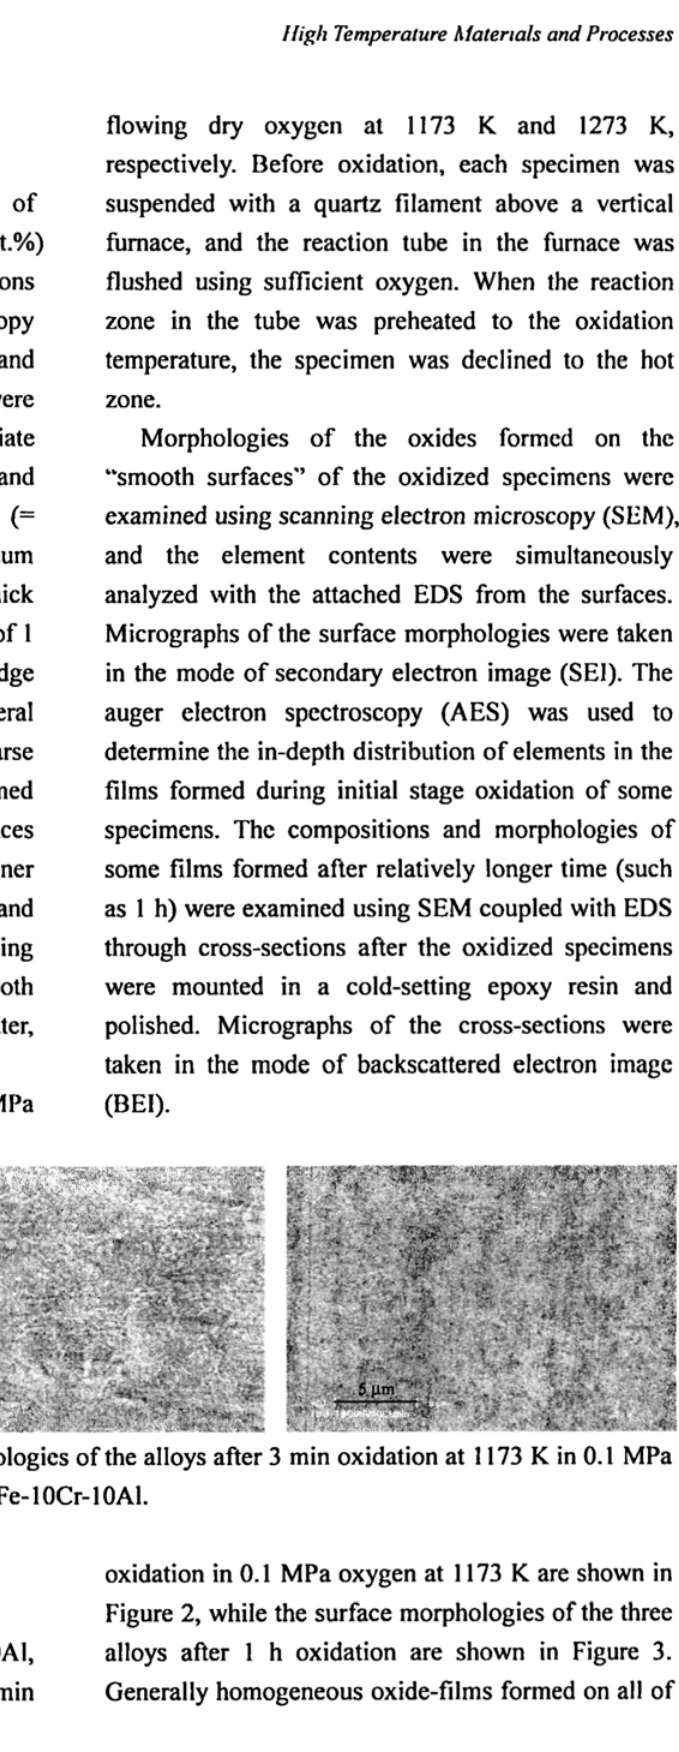
Fig. 2: Micrographs (SEM/SEI) of surface morphologies of the alloys after 3 min oxidation at 1173 K in 0.1 MPa O . (a) Fe-10Al, (b) Fe-5Cr-10Al, and (c) 2